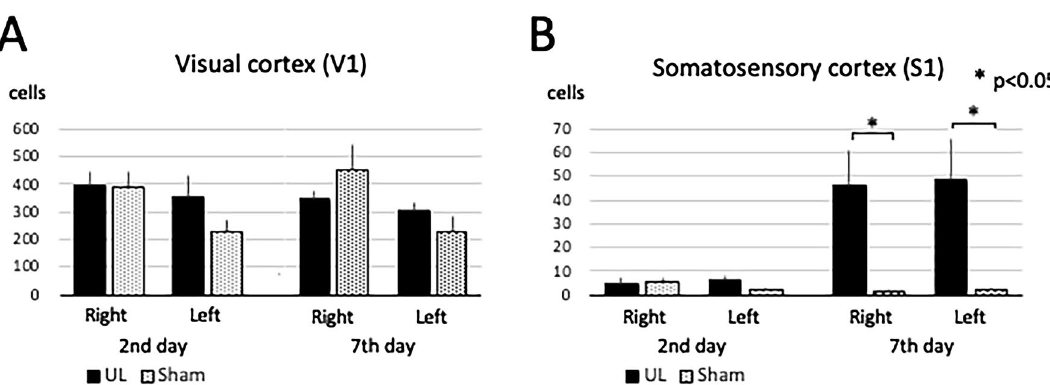
Figure 6. Activated neurons in V1 and S1. ( A ) Activated neurons in the visual cortex (V1). There were no significant differences in V1 between the UL and the sham-treated group. ( B ) Activated neurons in the somatosensory cortex (S1). There were significantly more activated neurons in the UL group than in the sham- treated group on day 7 after surgery. Error bars indicate the standard error of the